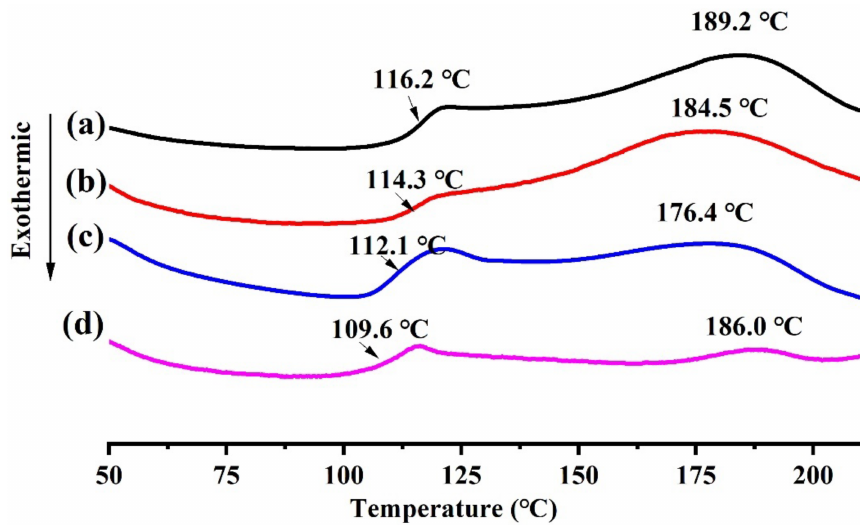
Figure 5. The DSC curves of the ( a ) PolyTi1, ( b ) PolyTi2, ( c ) PolyTi3 and ( d )